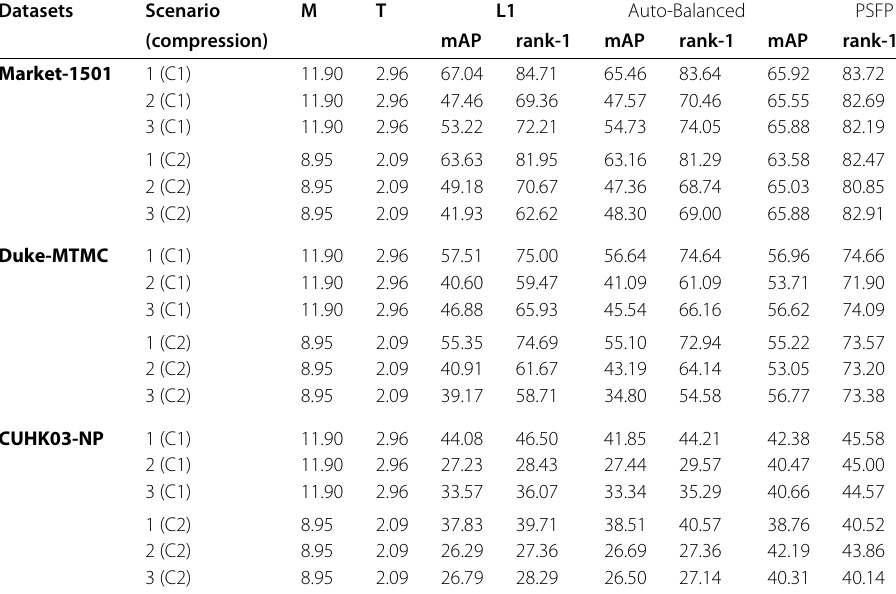
Table 7 Comparison of network accuracy (mAP and rank-1) and complexity (M: memory (parameters) and time: T (GFLOPS)) with different pruning compression ratios of different scenarios on all the ReID datasets